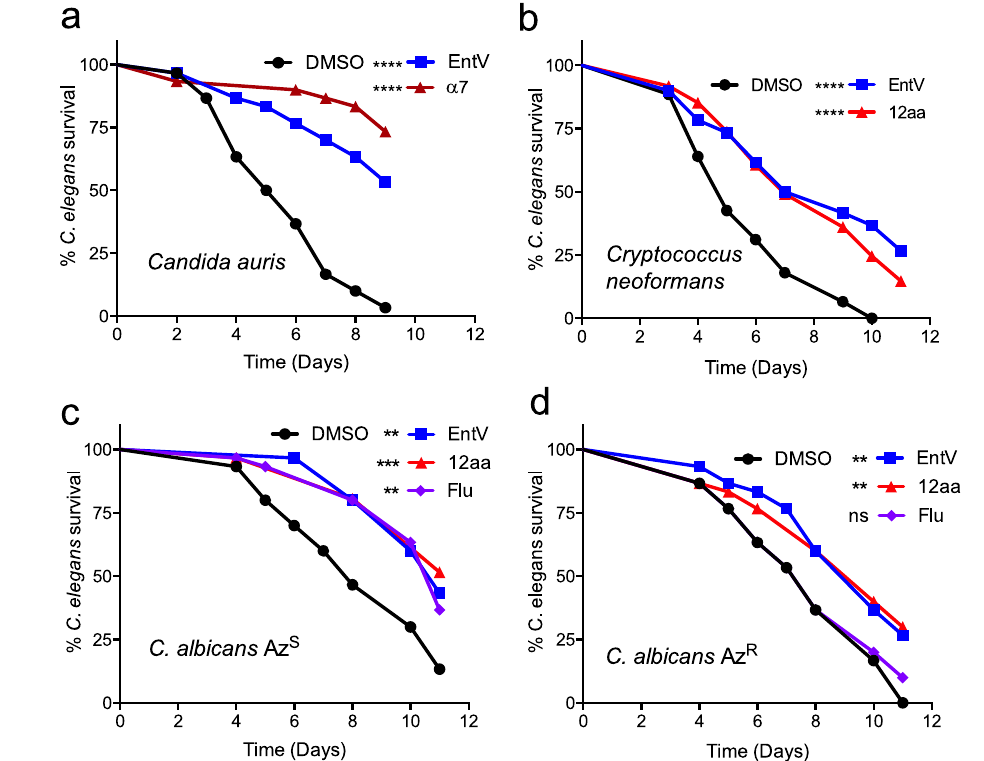
Fig. 4 | EntV peptides have activity against other fungal species and strains. Survival over time of C. elegans infected with C. auris , a , C. neoformans , b , and C. albicans pairedclinicalisolatesbefore(Az S )andaftergaining fl uconazoleresistance (Az R ), c . Peptides were added at 1nM and fl uconazole at 4ug/ml. Statistical dif- ferences in survival were compared to animals to the DMSO vehicle control by